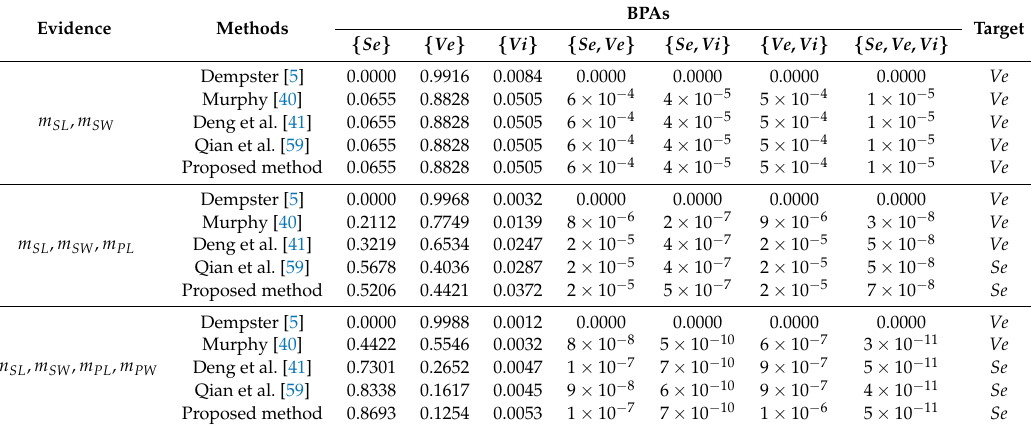
Table 6. The comparison of different methods applied in the Iris data set classification.